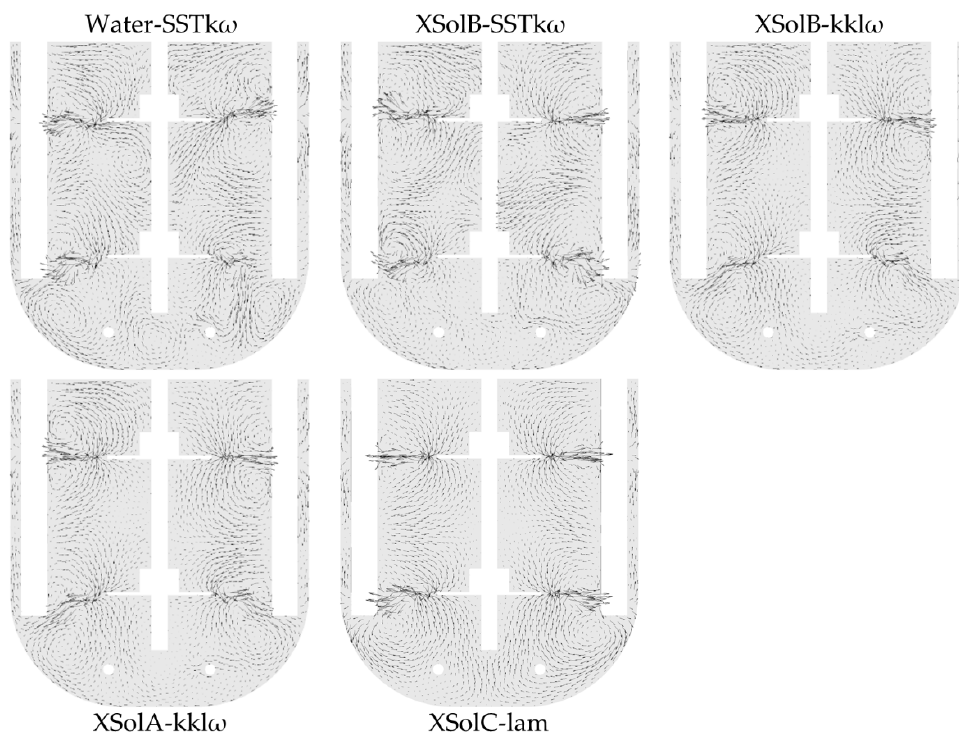
Figure 8. Comparison of the instantaneous velocity vectors, after the simulation of 58 impeller turns, between the different abiotic systems, at the middle plane across the impellers.